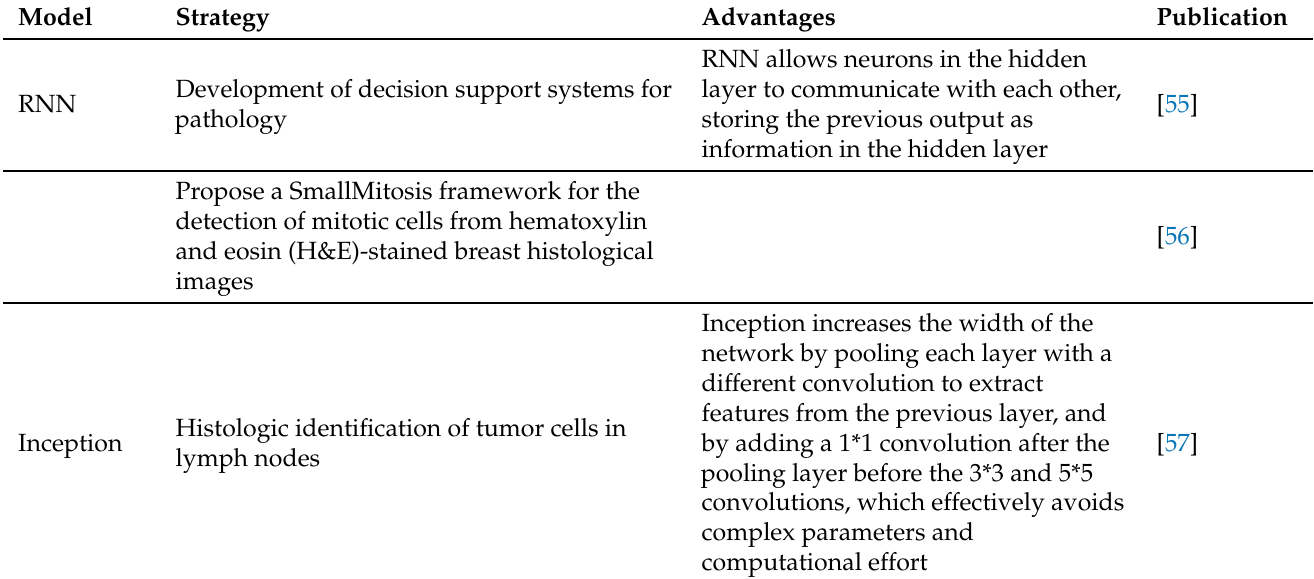
Table 2. Summary of the application of deep learning algorithms in breast cancer histopathology for